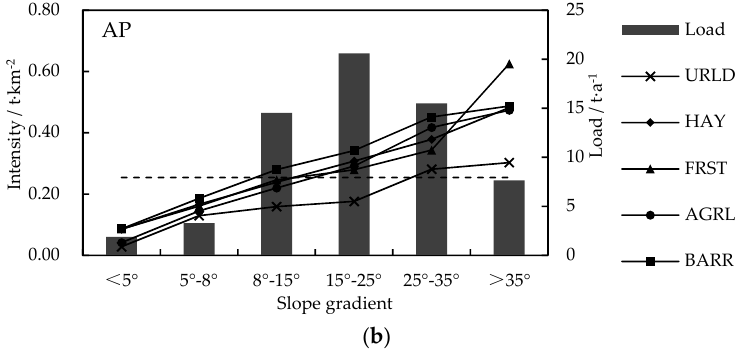
Figure 12. ( a ) AN and ( b ) AP loads and intensities for different slope gradients.